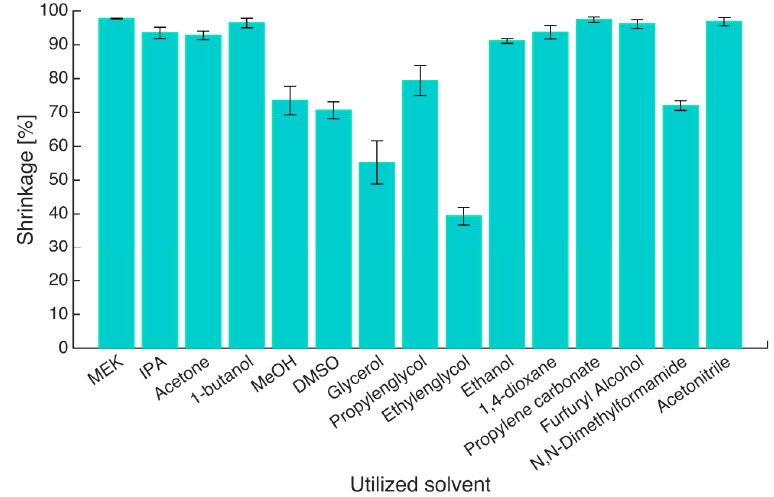
Figure 1. Pictures of shrunk gels compared to an original hydrogel. The hydrogels are placed on the left in each picture, and on the right are the gels once soaked in ( a ) methyl ethyl ketone (MEK); ( b ) isopropanol (IPA); ( c ) acetone; ( d ) 1-butanol; ( e ) methanol (MeOH); ( f ) dimethyl sulfoxide (DMSO); ( g ) glycerol; ( h ) propylene glycol; ( i ) ethylene glycol; ( j ) ethanol; ( k ) 1,4-dioxane; ( l ) propylene carbonate; ( m ) furfuryl alcohol; ( n ) N , N - dimethylformamide (DMF) and ( o ) acetonitrile.